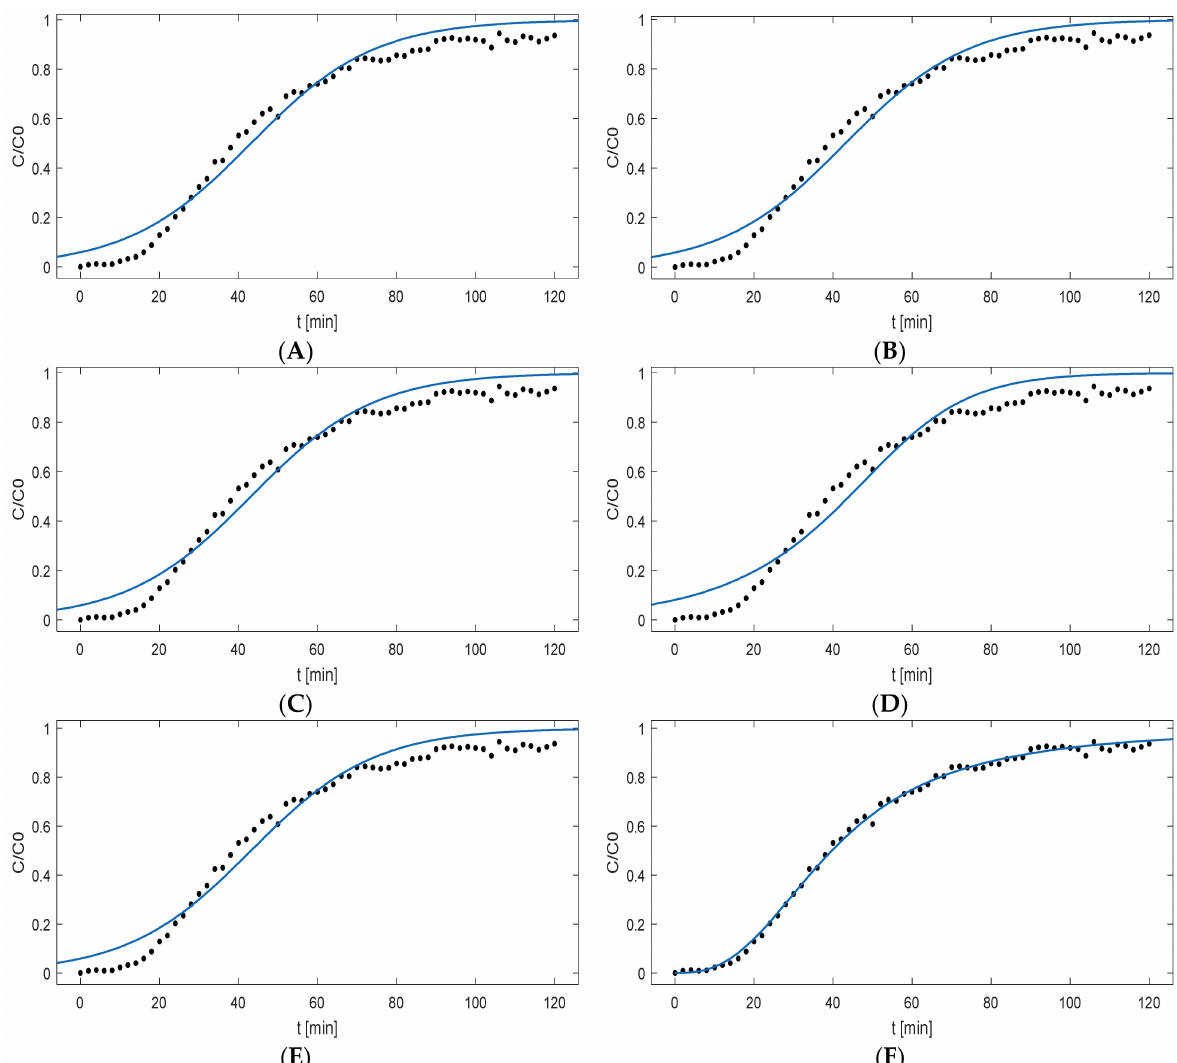
Figure 7. Graphical representation of models describing sorption of mercury on a hydrochar bed column system: ( A ) Bohart–Adams; ( B ) Thomas; ( C ) Yoon–Nelson; ( D ) Clark; ( E ) BDST; ( F )